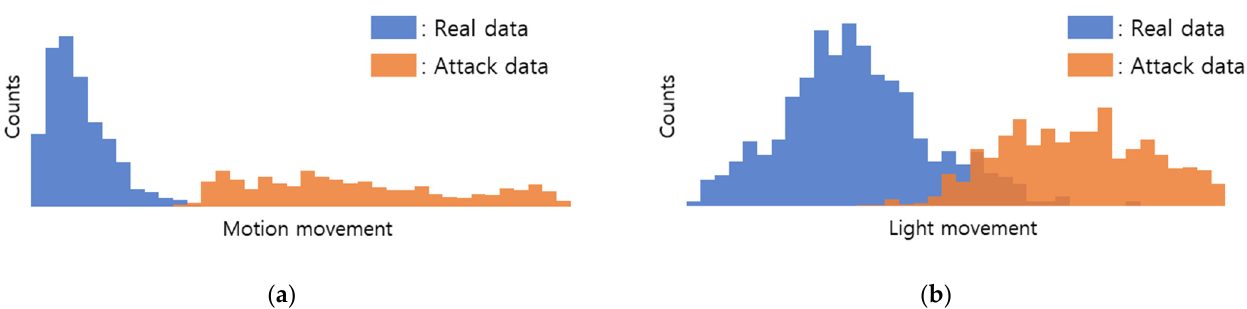
Figure 5. Motion value changes according to time domain.